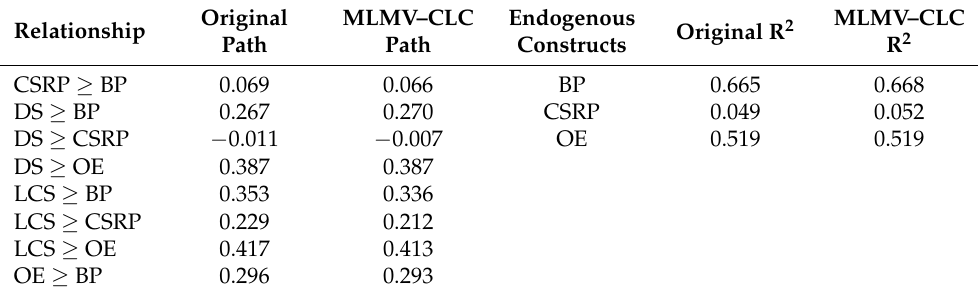
Table 1. Measurement Latent Marker Variable–Construct Level Correction.